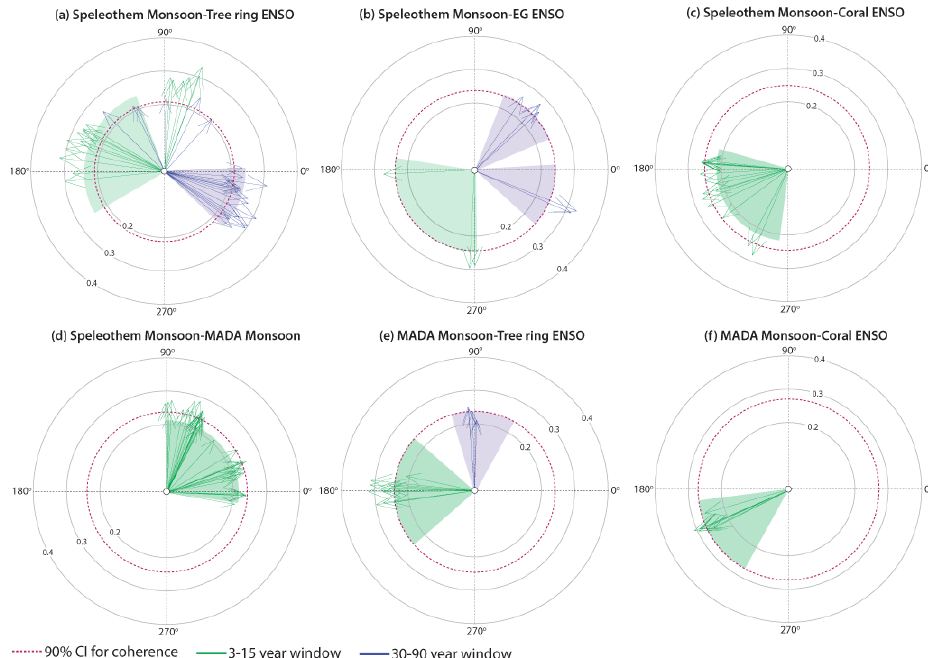
Fig. 4. Results from cross-spectral analysis between all proxy time series shown in Fig. 3. Arrows to the right indicate time series that are in phase with one another, while arrows to the left indicate time series that are anti-phased. Only arrows are shown when coherence between the time series is significant at the 90% confidence interval. The length of the arrow indicates the strength of the coherence, and the concentric circles indicate increasing (labeled) levels of coherence. The shaded wedges indicate estimates of uncertainty, which accounts both for age model uncertainties and those that arise from noise in the time series. All green arrows and wedges are for phasing in the high-frequency (5–15yr) window, and purple arrows and wedges are for phasing in the low-frequency (30–90yr) windows. Lastly, the speleothem and coral time series were inverted such that for all analysis arrows to the left (right) indicate strong (weak) monsoon associated with weak ENSO. (a) Speleothem ISM (Sinha et al., 2011) against tree ring ENSO (Li et al., 2011), (b) speleothem ISM (Sinha et al., 2011) against composite ENSO (Emile-Geay et al., 2013), (c) speleothem ISM (Sinha et al., 2011) against coral ENSO (Cobb et al., 2003), (d) speleothem ISM (Sinha et al., 2011) against MADA ISM (Cook et al., 2010), (e) MADA ISM (Cook et al., 2010) against tree ring ENSO (Li et al., 2011), and (f) MADA ISM (Cook et al., 2010) against coral ENSO (Cobb et al.,